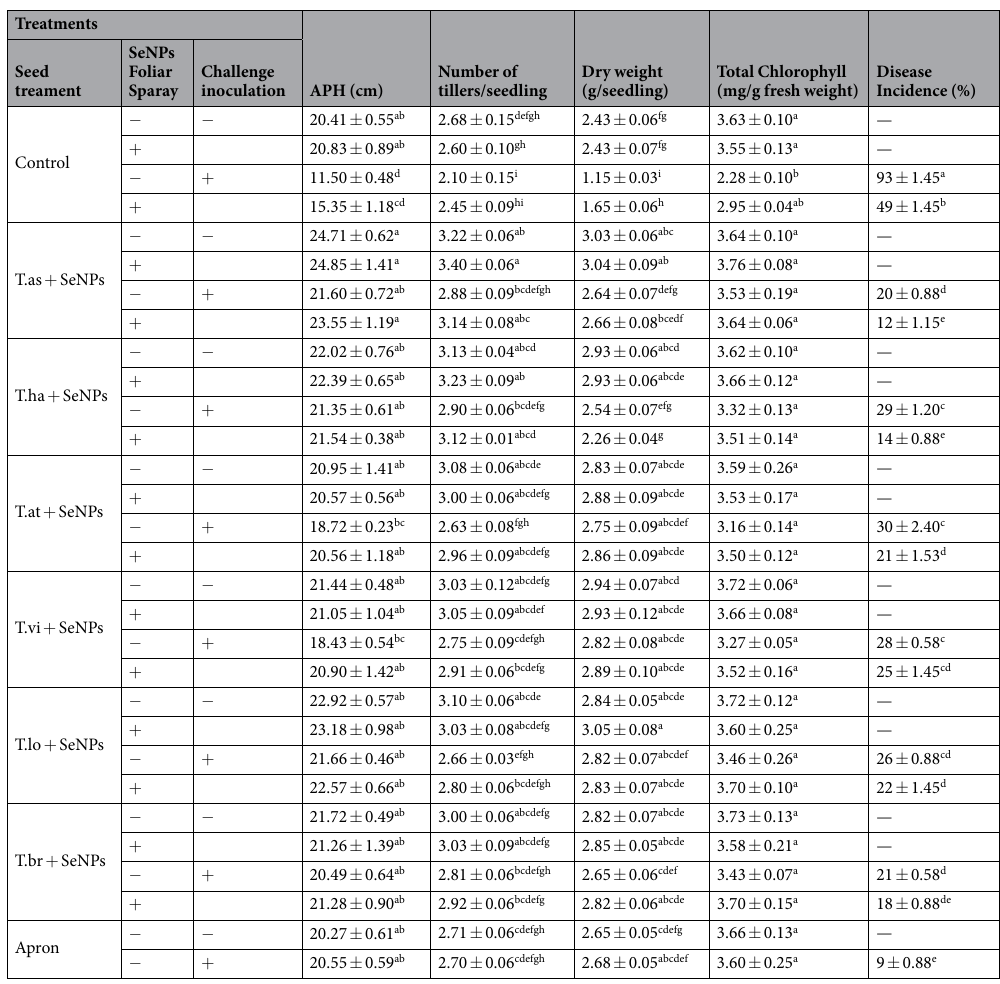
Table 2. Effect of combined application of Trichoderma and T.as-CF-SeNPs on growth parameters and downy mildew disease incidence in pearl millet. APH - average plant height; T.as - T . asperellum ; T.ha – T . harzianum ; T.vi – T . virens ; T.lo – T . longibrachiatum ; T.at – T . atroviride ; T.br – T . brevicompactum . Values are the mean of three replicates; values within column sharing the same letter(s) are not significantly different according to Tukey’s HSD at P ≤